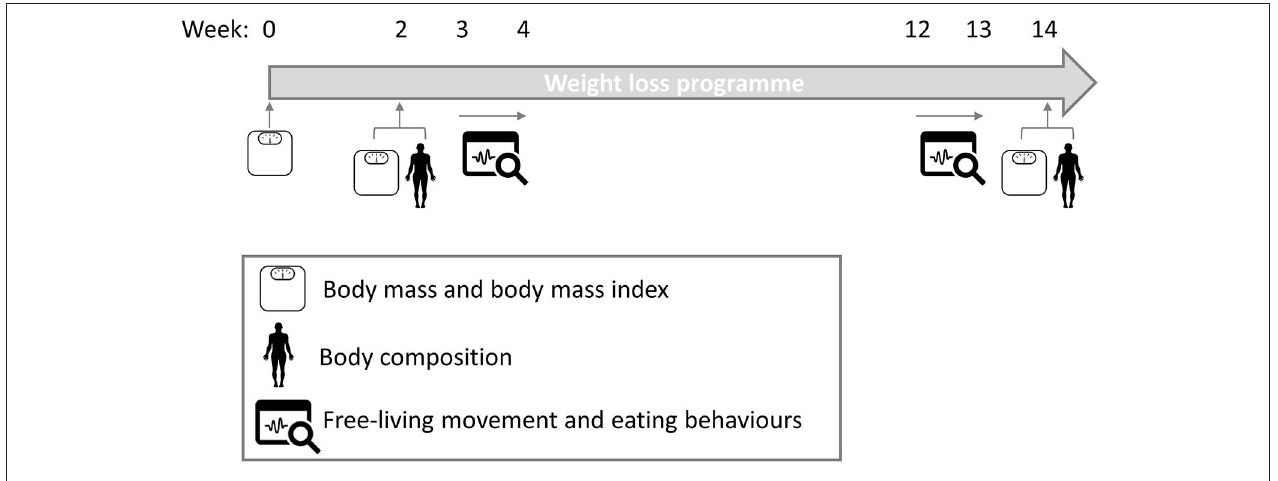
FIGURE 1 | Schematic diagram of study